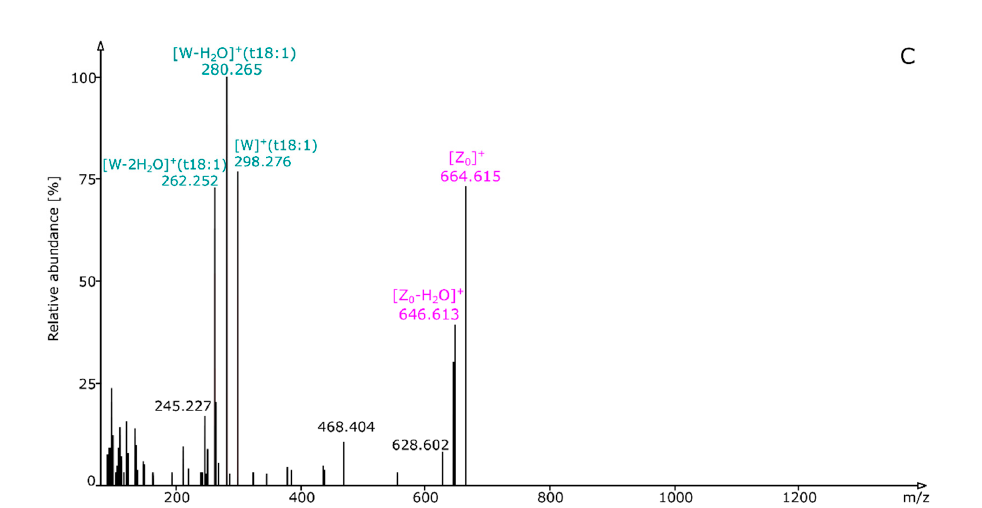
Figure 2. Overview of the GIPC fragmentation for the example of GIPC A-OH-t18:1 / h24:0 in salad: ( A ) The fragment assignment of GIPC A-OH-t18:1 / h24:0 (adapted from [23]). The W fragment is shown in a light blue color. Please note that a full structural characterization is not possible by RP-HRMS / MS, ( B ) The product ion spectrum in negative ion mode at m / z 1260.7237, showing characteristic fragments m / z 241 and 259, 355, 373 and 417. The sugar head group was confirmed by the [C 3 PO 3 ] − fragment ( m / z 597, R1 = OH). [Z 0 PO 3 ] − and [Y 1 -H] − fragments prove the ceramide moiety. ( C ) The positive ion mode ddMS2 spectrum of the [M + H] + precursor, exhibiting the [W] + , [W-H 2 O] + and [W-2H 2 O] + fragments at m / z 298, 280 and 262, which are characteristic for the t18:1